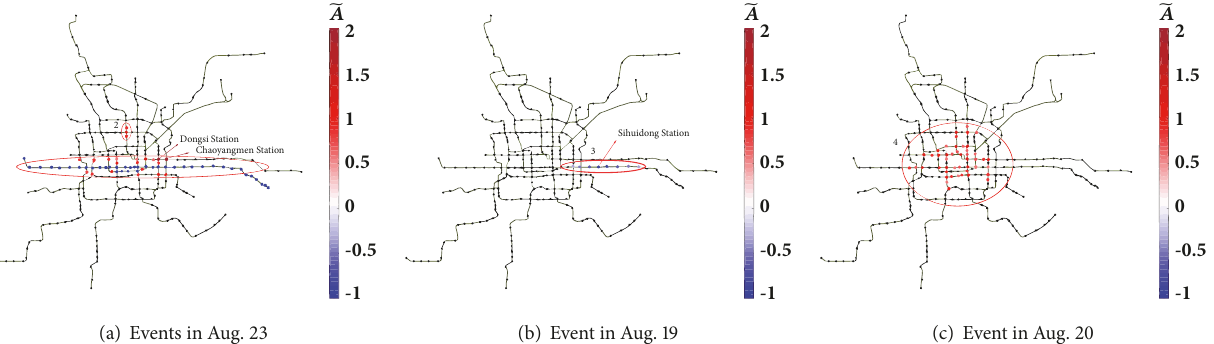
Figure 7: Anomaly events (labeled with ellipse). Red points mean traffic flow increasing and blue points mean traffic flow declining. We ̃ A = A / X ̃ A normalize anomaly A to get and values of denotes deviation from the